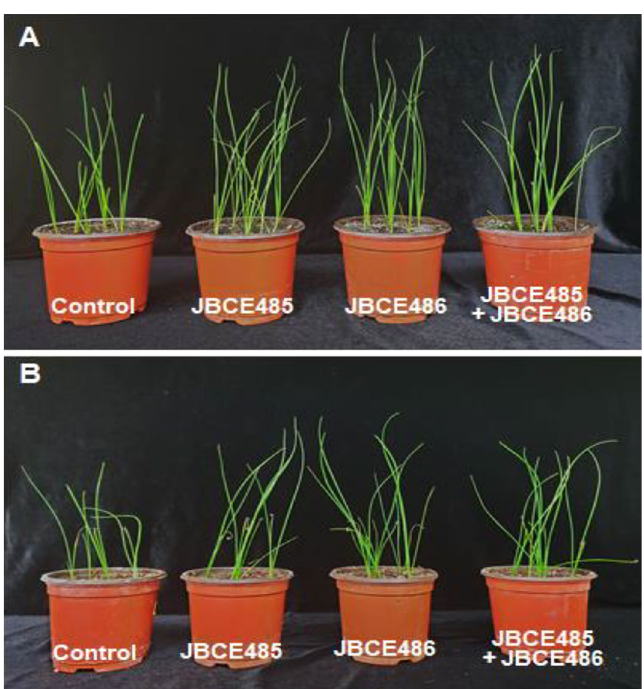
Figure 8. Stress alleviation of chive by treatment with Pseudoxanthomonas sp. JBCE485 and Variovorax paradoxus JBCE486. Chive seeds were surface sterilized and treated with 1 × 10 7 CFU/mL cells of individual and combination of JBCE485 and JBCE486. Seeds were grown on normal horticultural soil soaked with tap water ( A ) with or ( B ) without 175 mM NaCl. Representative photos of plants were taken after 4 weeks and 6 weeks of treatment in soil without or with salt,